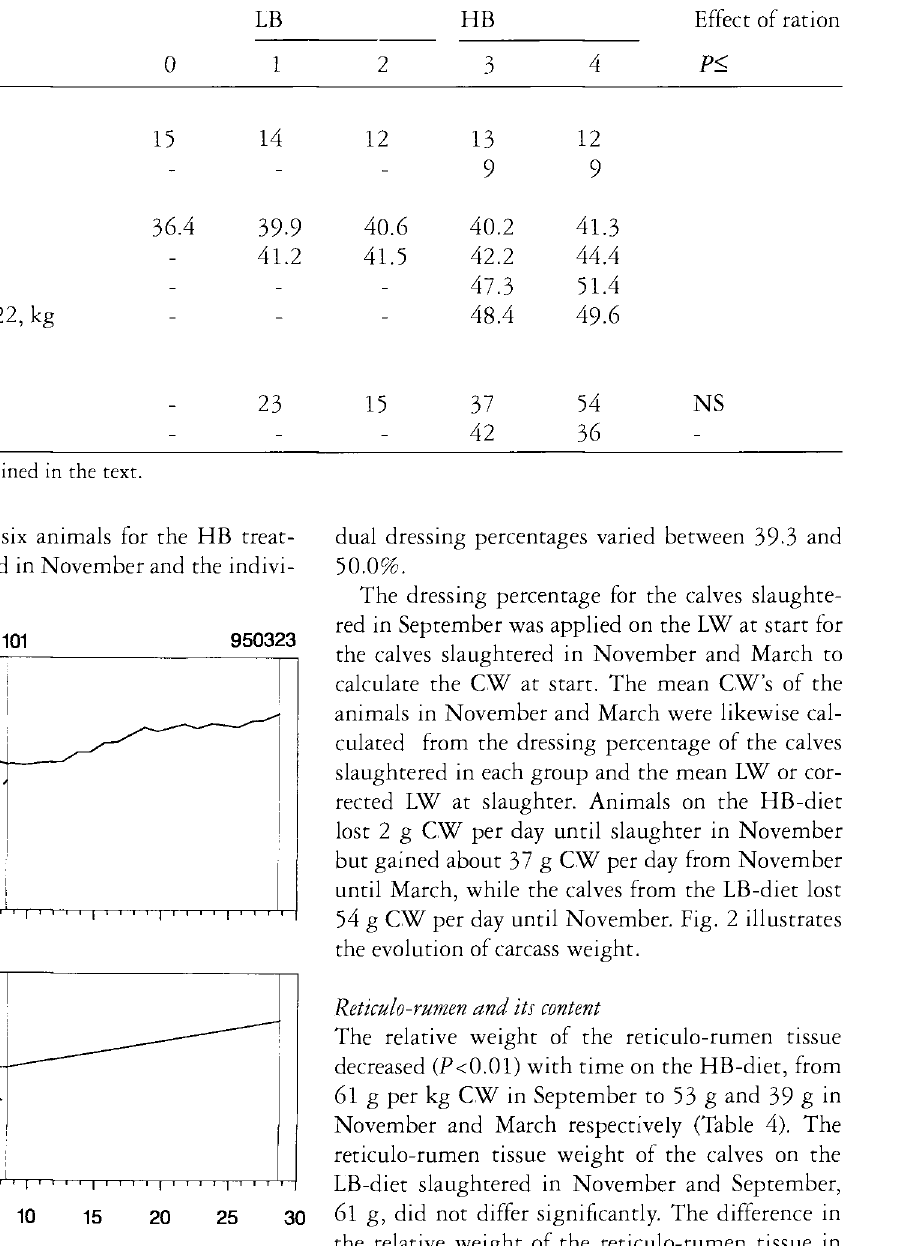
Fig. 2. Evolution of live weight (LW) and carcass weight (CW), respectively, for reindeer calves fed diets with low, 30% (LB, -), or high, 60% (HB, -), proportions of barley in the dry matrer. From November 1 corrected LW are used (see